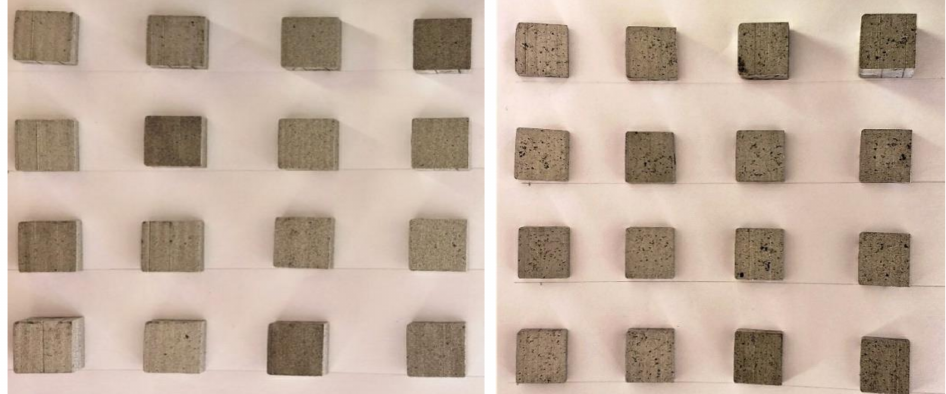
Figure 2. Cut surface of the machined